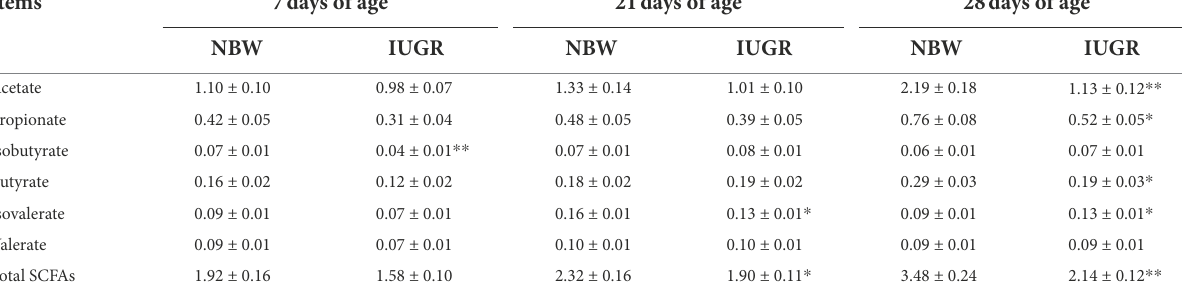
TABLE 2 Differences in colonic short-chain fatty acids (SCFAs) levels between the IUGR and NBW piglets (mg/g). Items